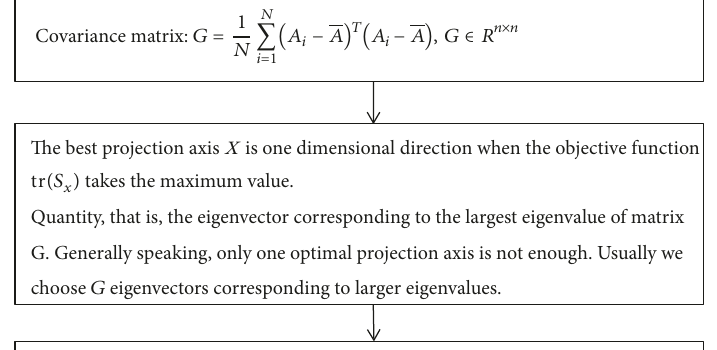
2DPCA algorithm principle: post projection Y i = A i